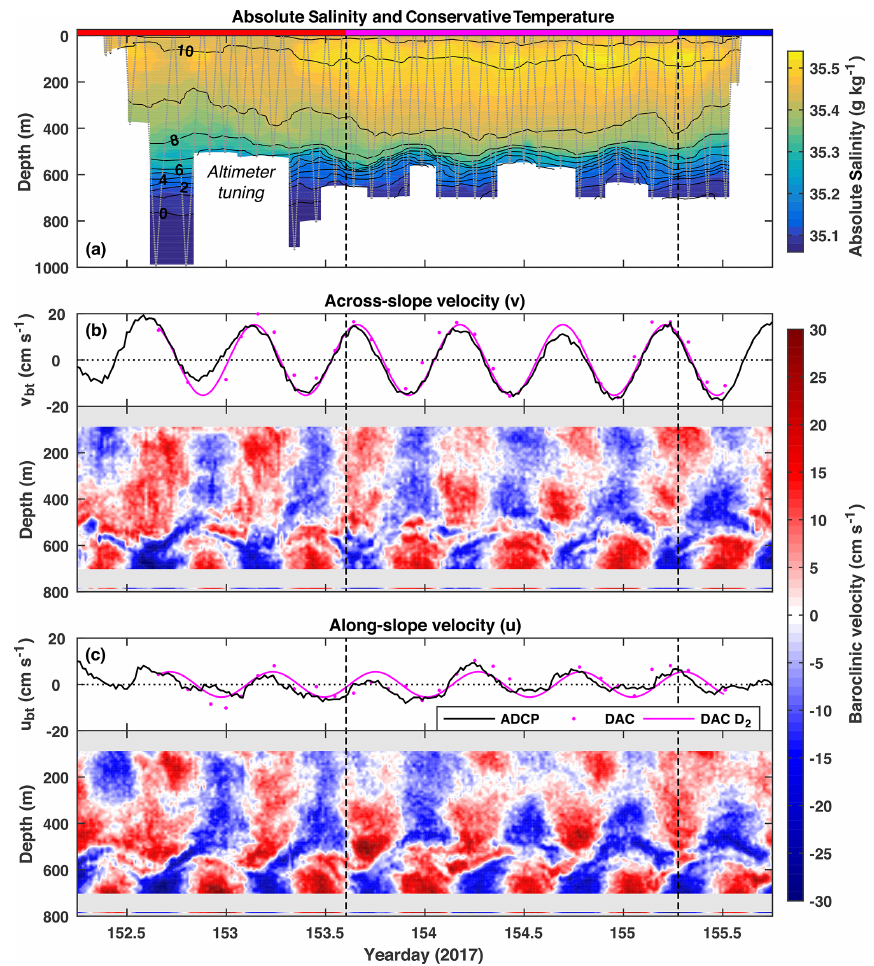
Figure 2. (a) Absolute Salinity (colour) and Conservative Temperature (black contours, interval: 1 ◦ C) measured by the glider. The dotted grey line is the glider’s path and shows the temporal sampling resolution. The magenta section is when the glider was on-station by the ADCP mooring. (b) Across-slope barotropic (black line) and baroclinic (colour) velocities measured by the ADCP and current meter and dive-average current (DAC) velocity inferred from the glider (magenta dots). The magenta line is a D 2 harmonic fit to DAC velocity. Positive velocities are northeast (down-slope). Panel (c) is the same as (b) but for along-slope velocities. Positive velocities are